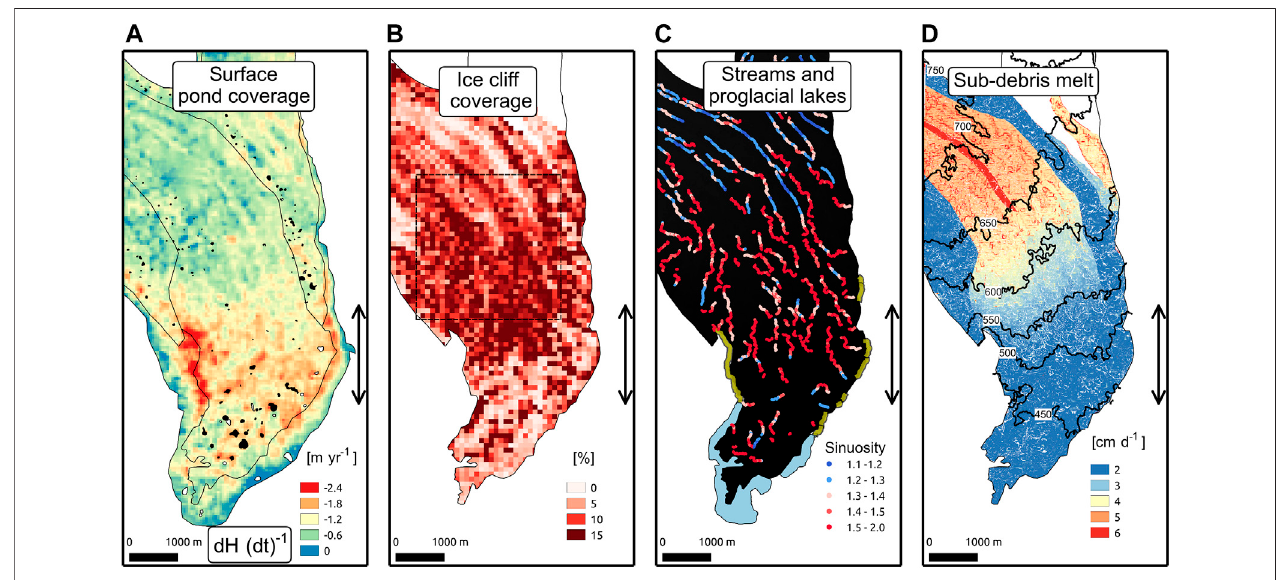
FIGURE6| Comparisonofthinning,melthotspots,andmeltinmapview.Thedoubleheadedarrowsindicatetheextentofthezoneofmaximumthinning(ZMT). (A) Glacier surface elevation change between 1957 and 2004 and observed surface pond extent in 1957 (white) and 2009 (black). The 1957 glacier extent is shown by the extent of the thinning map. The 2015 glacier outline is shown in black, as is the boundary between the central 5 medial moraines (compare with panel D). (B) Ice cliff coverageinfractionalarea × 100(percent)fromAndersonetal.(2021)witha100 mgrid.Theblackboxshowstheextentofeachpanelin Figure4 . (C) Supraglacial streamextentandsinuosityacrossthestudyarea.Icemarginalstreamsdigitizedfromthe2009WorldViewimageareshownasyellowlines.Theproglaciallakein2009is shown in blue. (D) Sub-debris melt estimates from the summer of 2011 (Anderson et al., 2021). Contours are derived from a 2015 DEM.